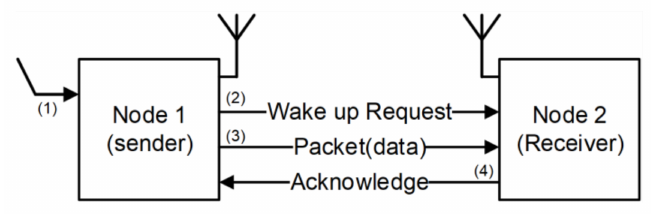
Figure 2. Simplified sensor node communication with a handshake